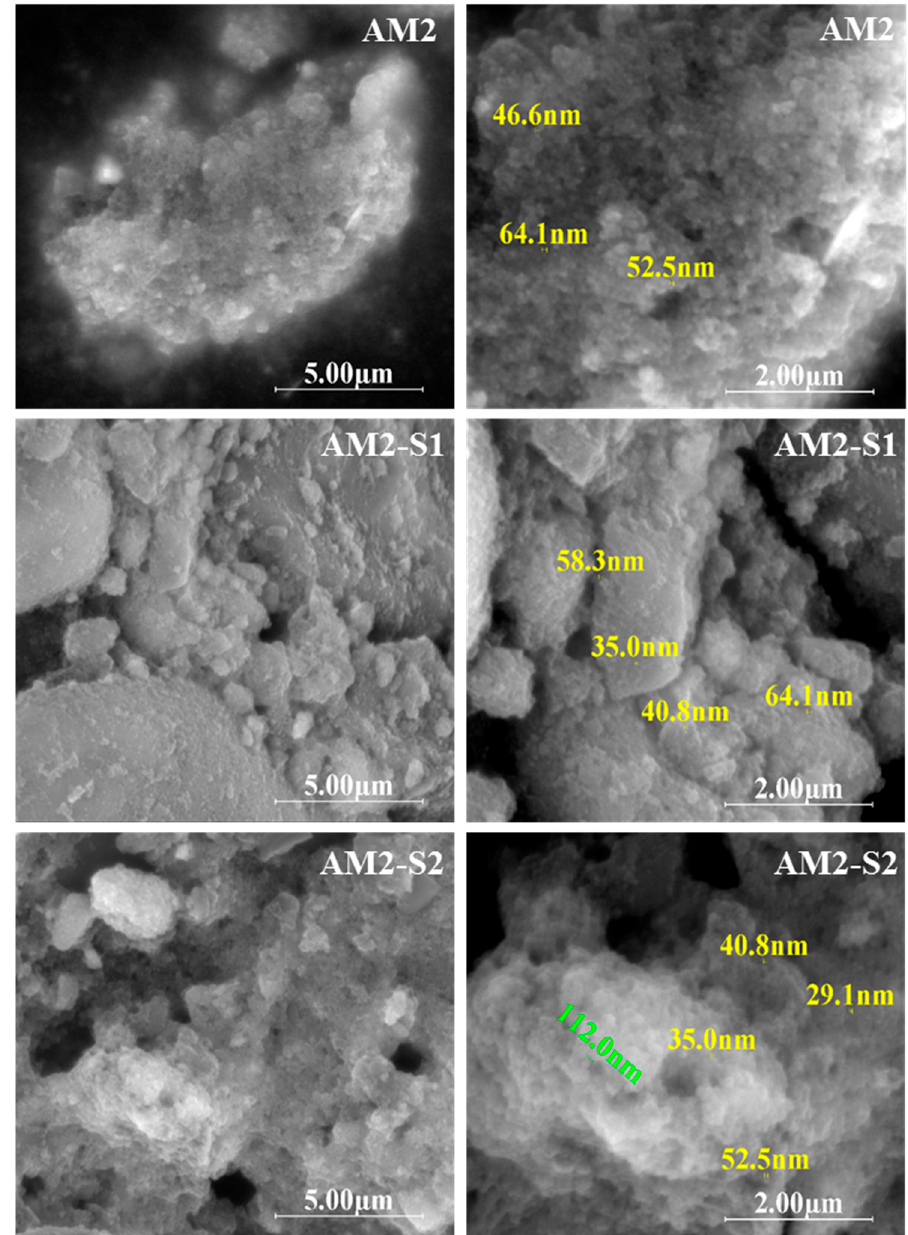
Figure 1. Top-view SEM images of Ag-decorated IONPs (AM1 and AM2) and the corresponding core–shell composites nanoparticles (AM1-S1/2 and AM2-S1/2). The biggest nanoparticle size indicates the agglomeration of the silver-decorated Figure S1 corresponds to hierarchically structured porous materials [52]. While